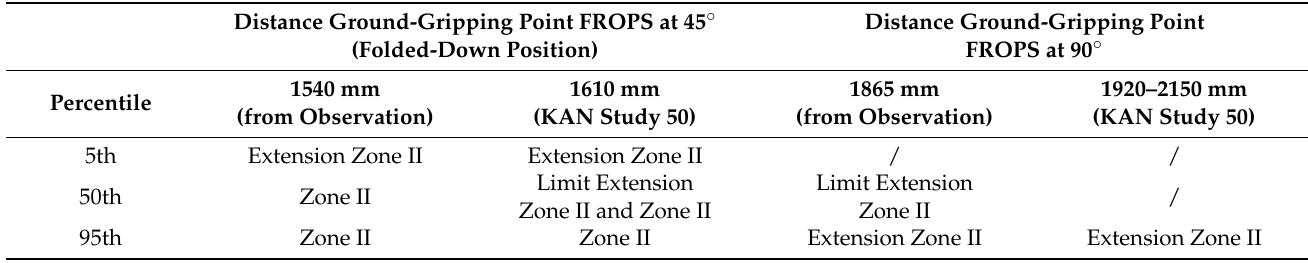
Table 2. Areas of the accessible zones in which the gripping point is at 45 ◦ and 90 ◦ roll-bar angle and respective height from the ground (in real and optimal conditions) for the three percentile